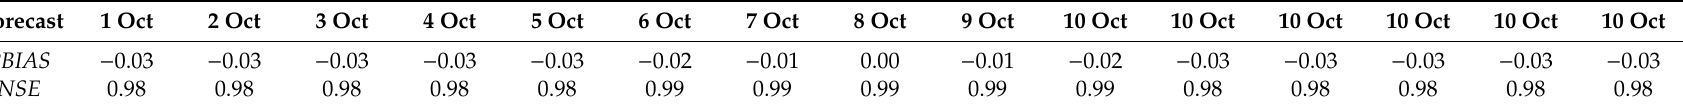
Table 3. Statistics of the simulated peak water elevations compared to the high water